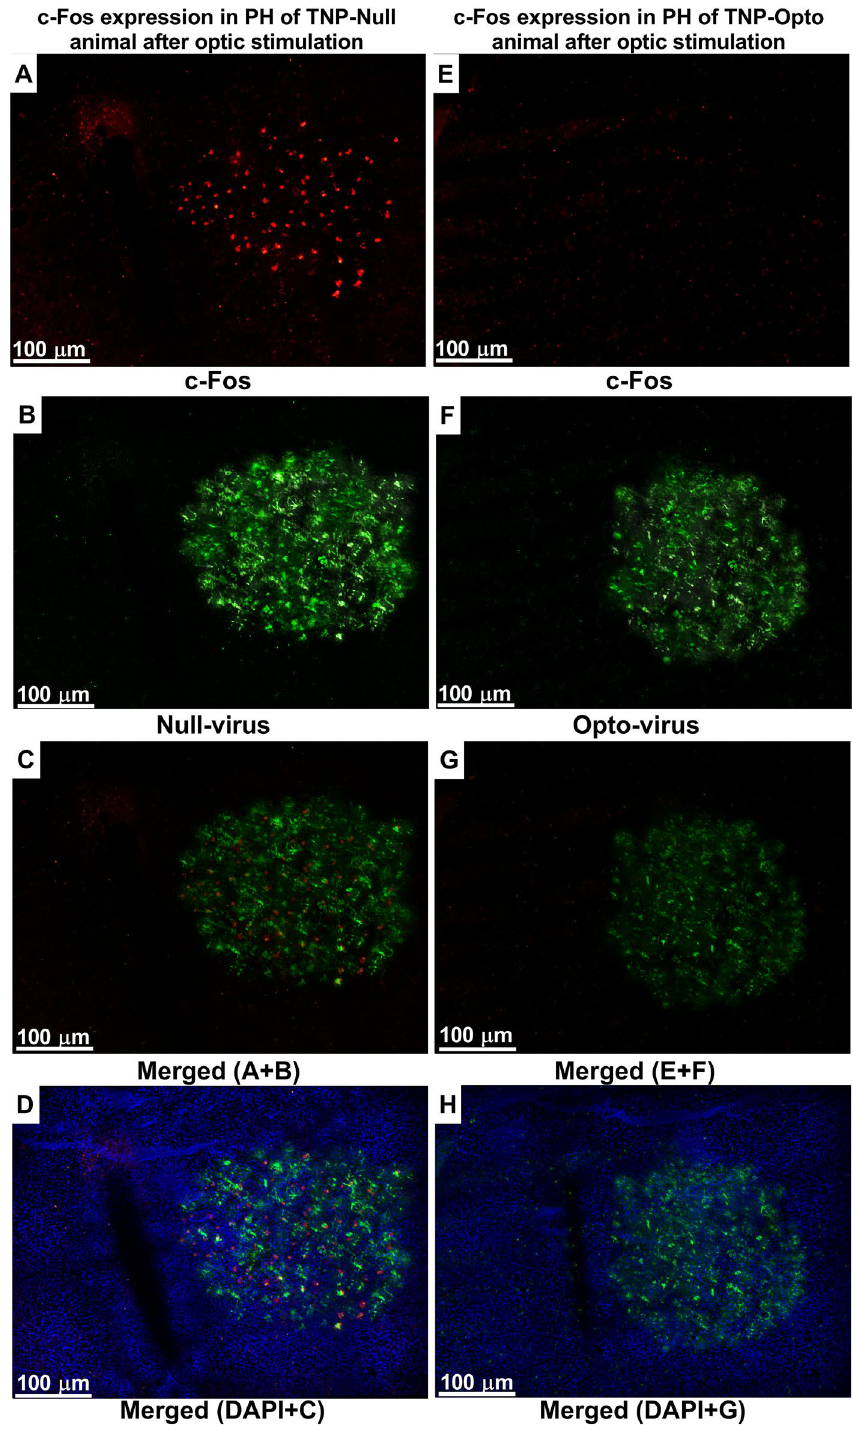
Figure 7. c-Fos expression in the PH of null virus- and opto virus-injected TNP animal after optogenetic stimulation. ( A – D ) c-Fos and null virus’ expression in the PH of TNP-Null animals: ( A ) expression of c-Fos- positive neurons, ( B ) Null virus’ expression in PH, ( C ) merged (c-Fos + Null-virus), ( D ) merged (c-Fos + Null- virus + DAPI). ( E – H ) c-Fos and opto virus’ expression in the PH of TNP-Opto animals: ( E ) alleviated c-Fos expression, ( F ) Opto virus’ expression in PH, ( G ) merged (c-Fos + Opto-virus), ( H ) merged (c-Fos + Opto- virus + DAPI). Scale bar = 100